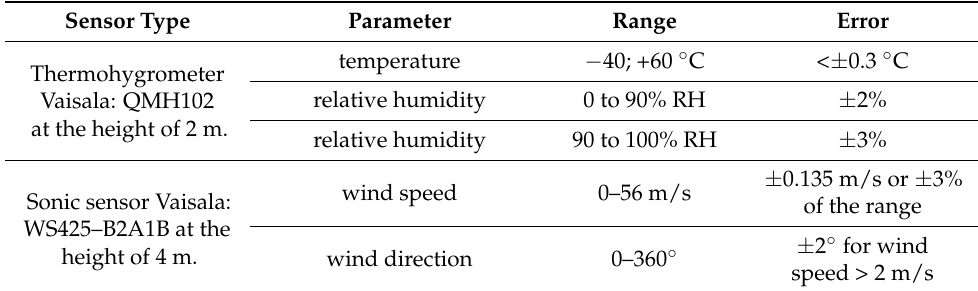
Table 1. Sensor types utilized for meteorological parameters